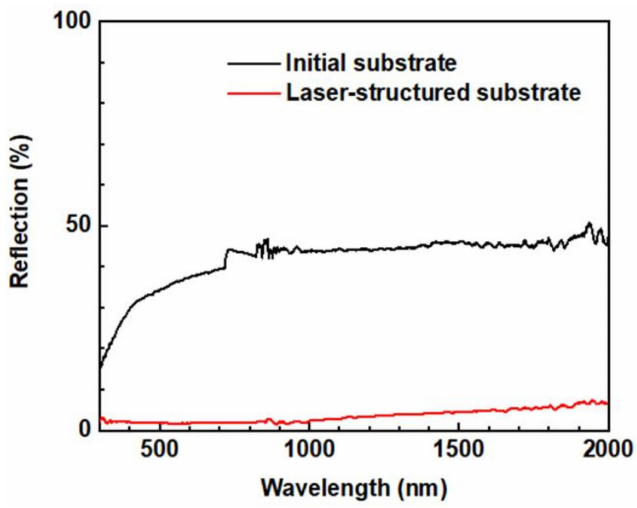
Figure 5. Surface reflectance spectra of initial titanium alloy substrate and laser-treated titanium alloy